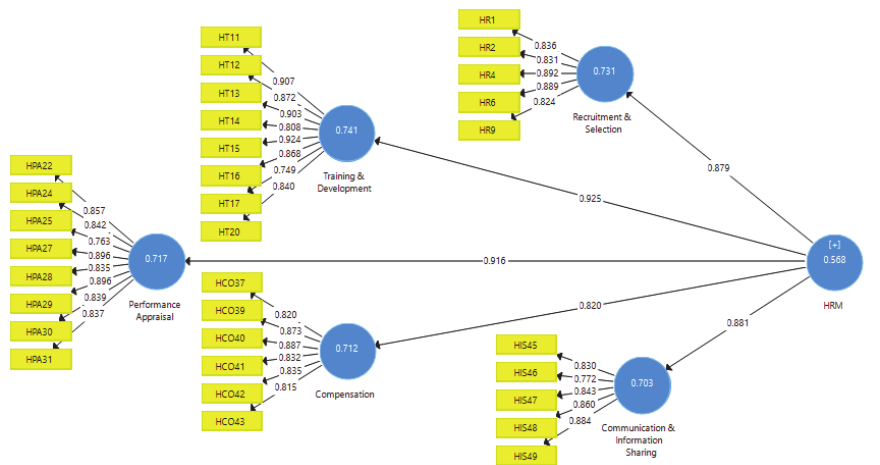
Fig. 1. Measurement Model of HRM